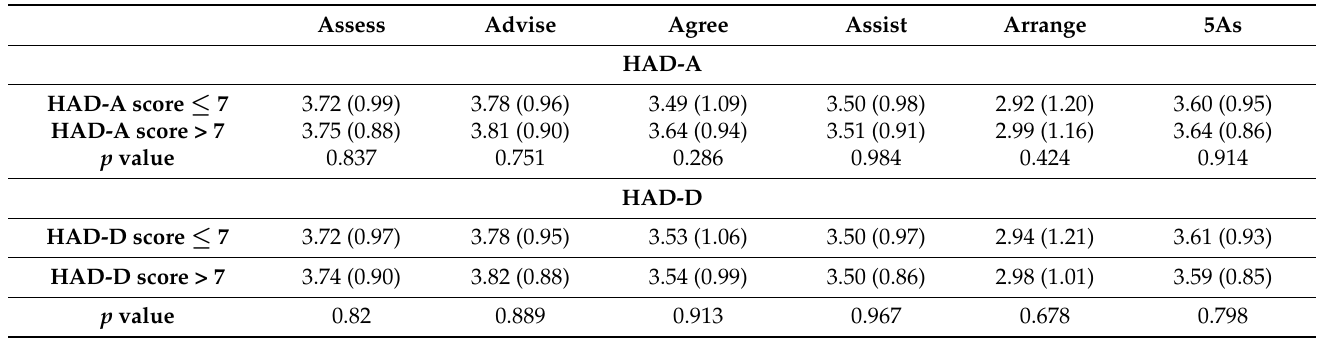
Table 6. The comparison of PACIC+ score according to the level of anxiety or depression (HAD scale). Data are presented as mean (standard deviation).